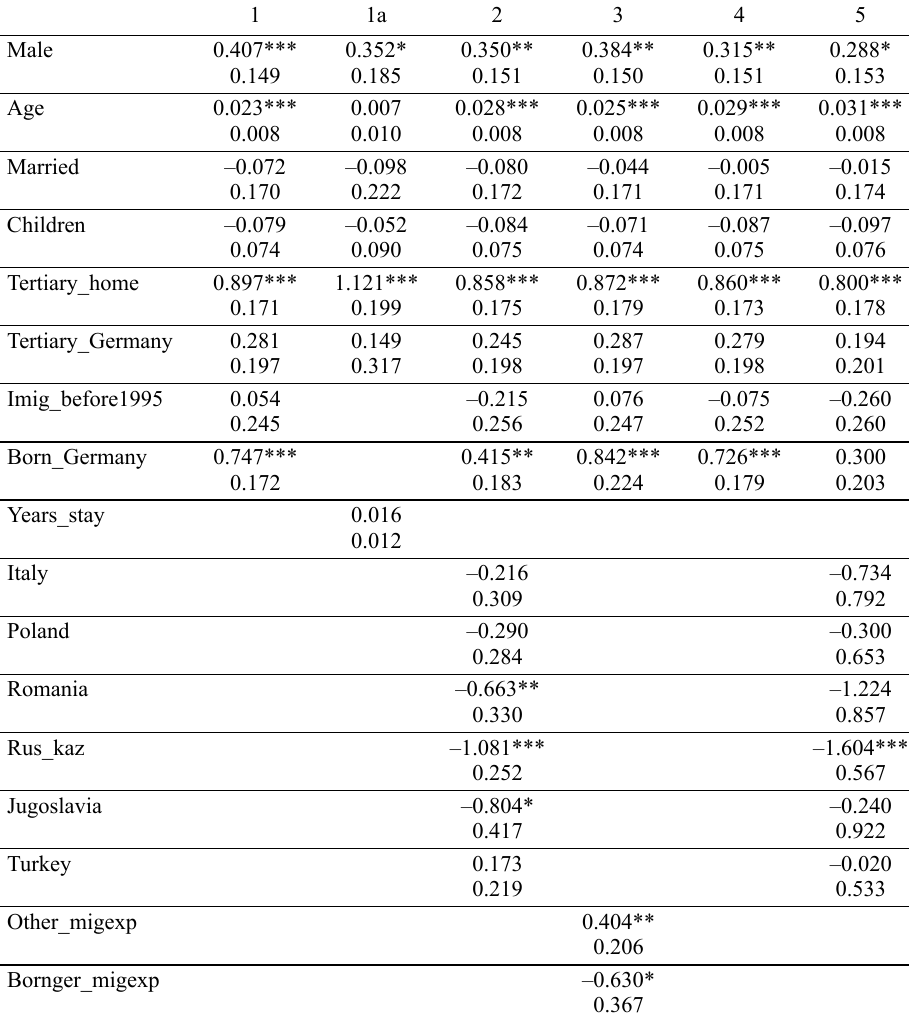
Table 2. Results of Firth corrected binomial logit regression on self-employment